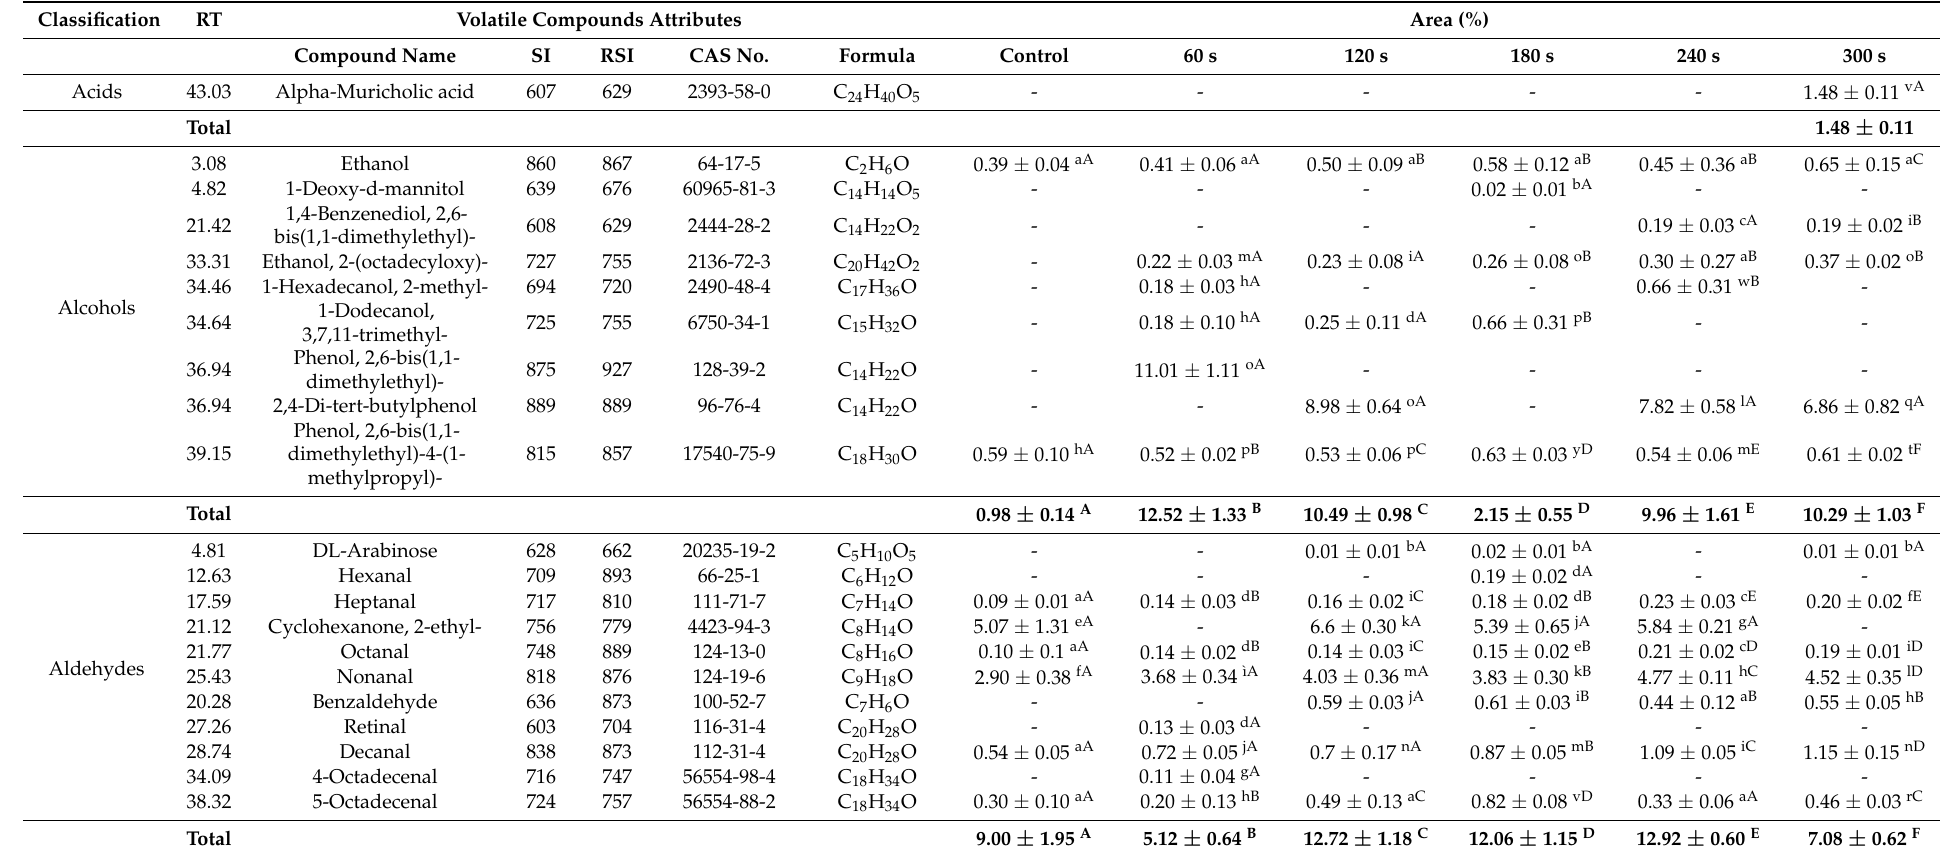
Table 2. Volatile compounds identified in the egg white protein-treated high-voltage cold plasma using